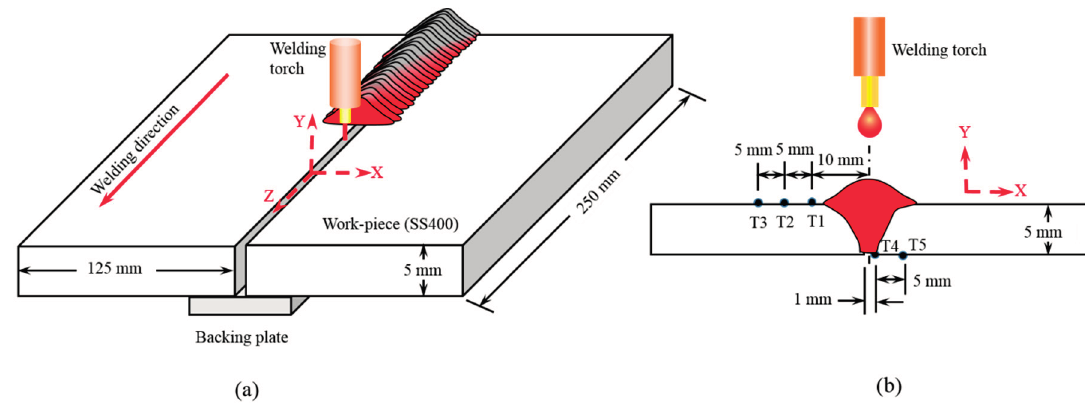
Figure 2. ( a ) Experimental schematics used in the welding tests ( b ) position of thermocouples on base plate.